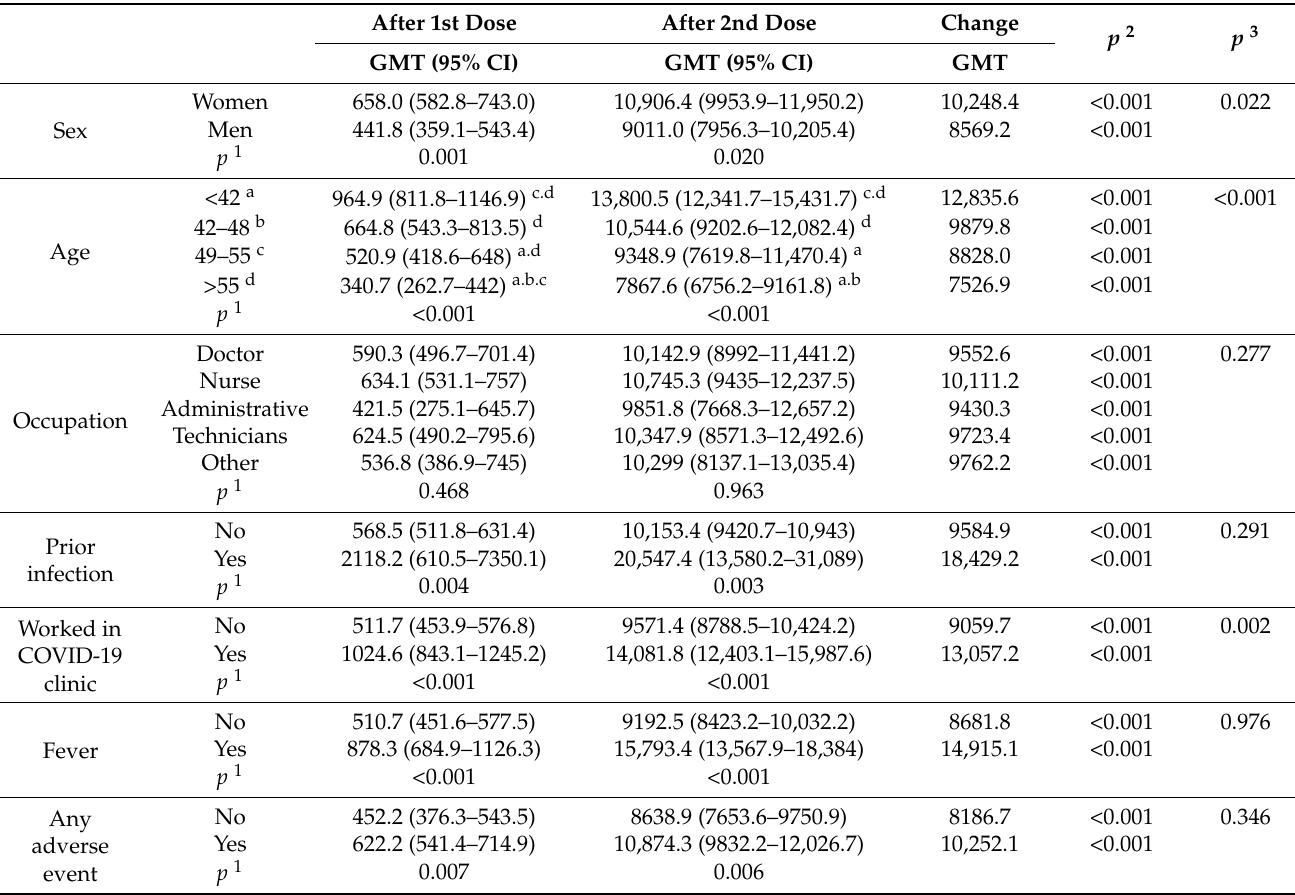
Table 3. Changes in antibody levels during